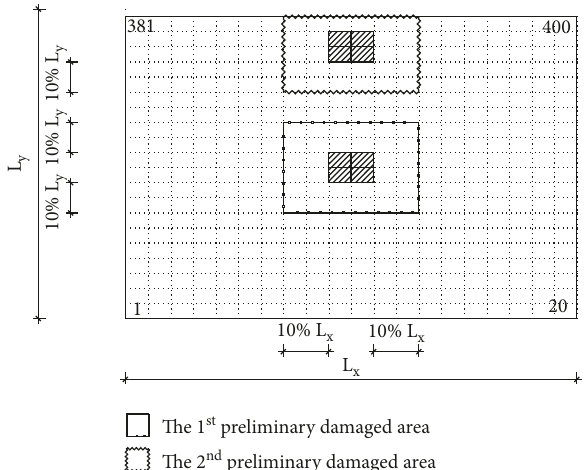
Figure 15: Two preliminary damaged areas detected from global MSE